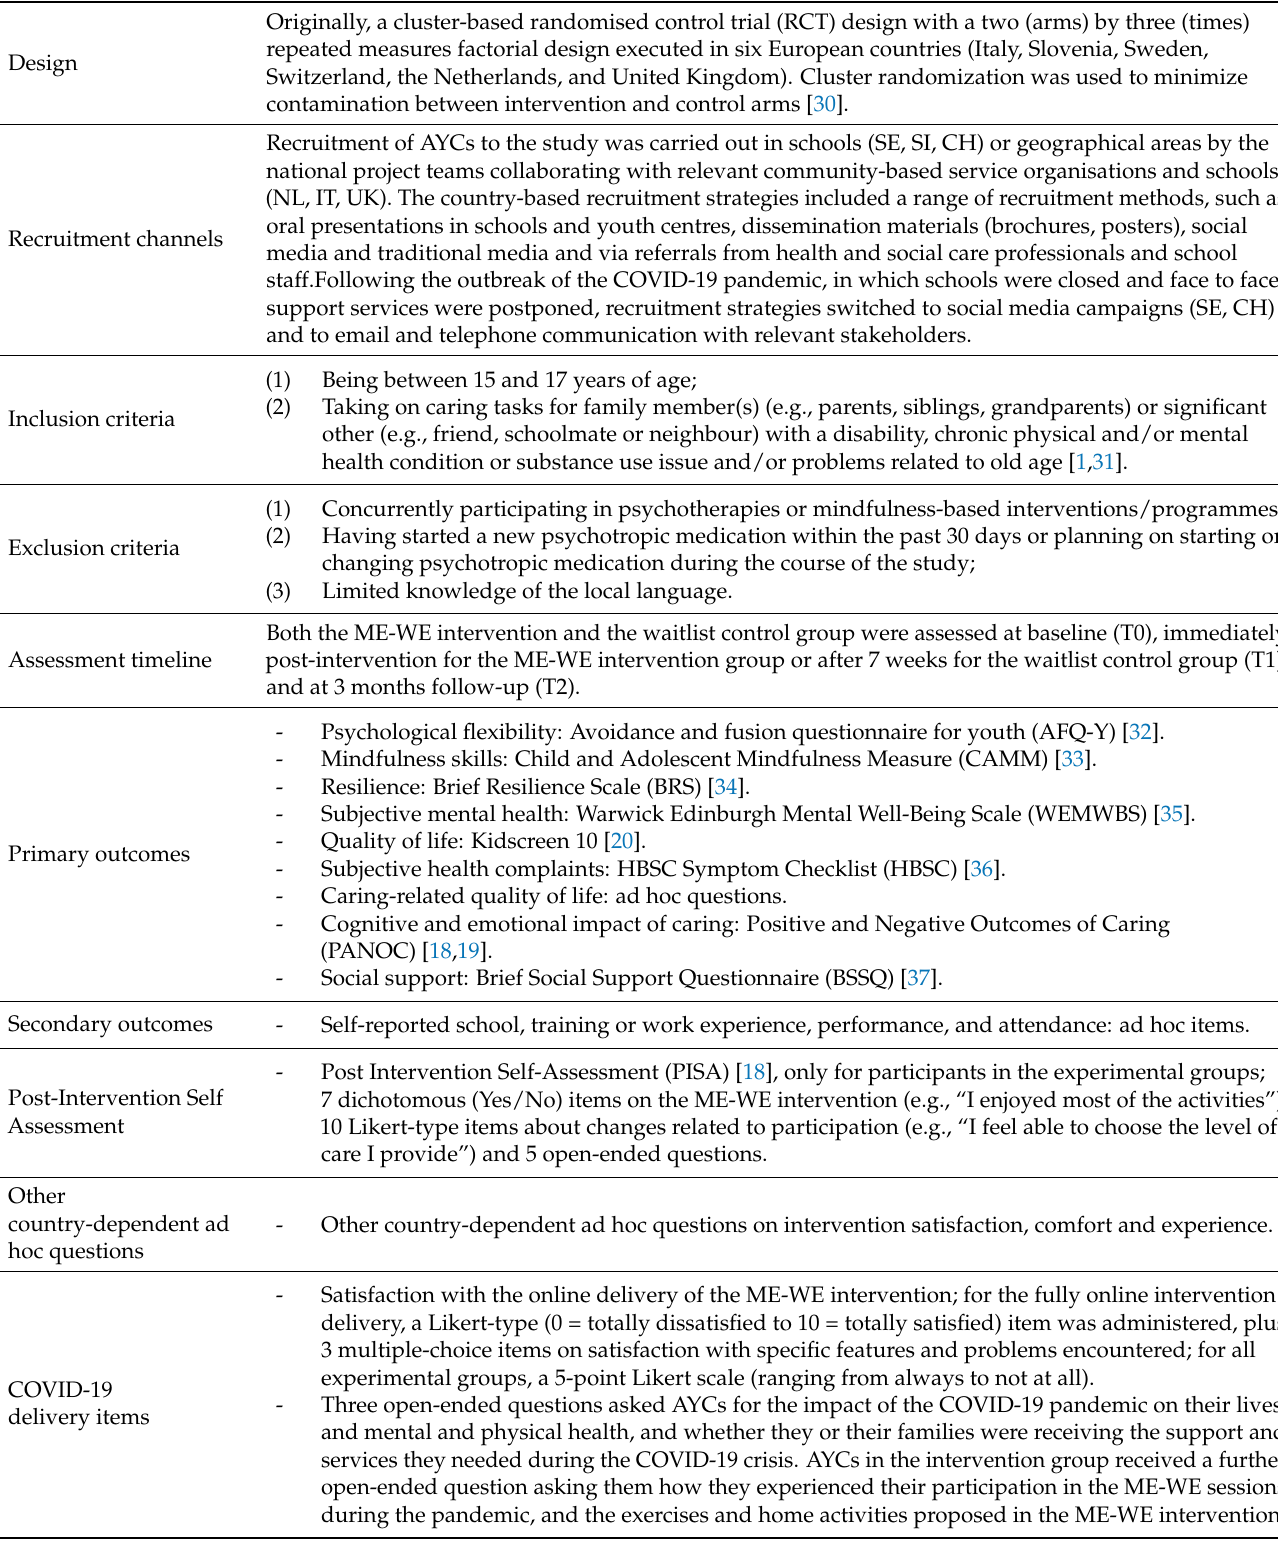
Table 1. ME-WE Clinical Trial Study summary